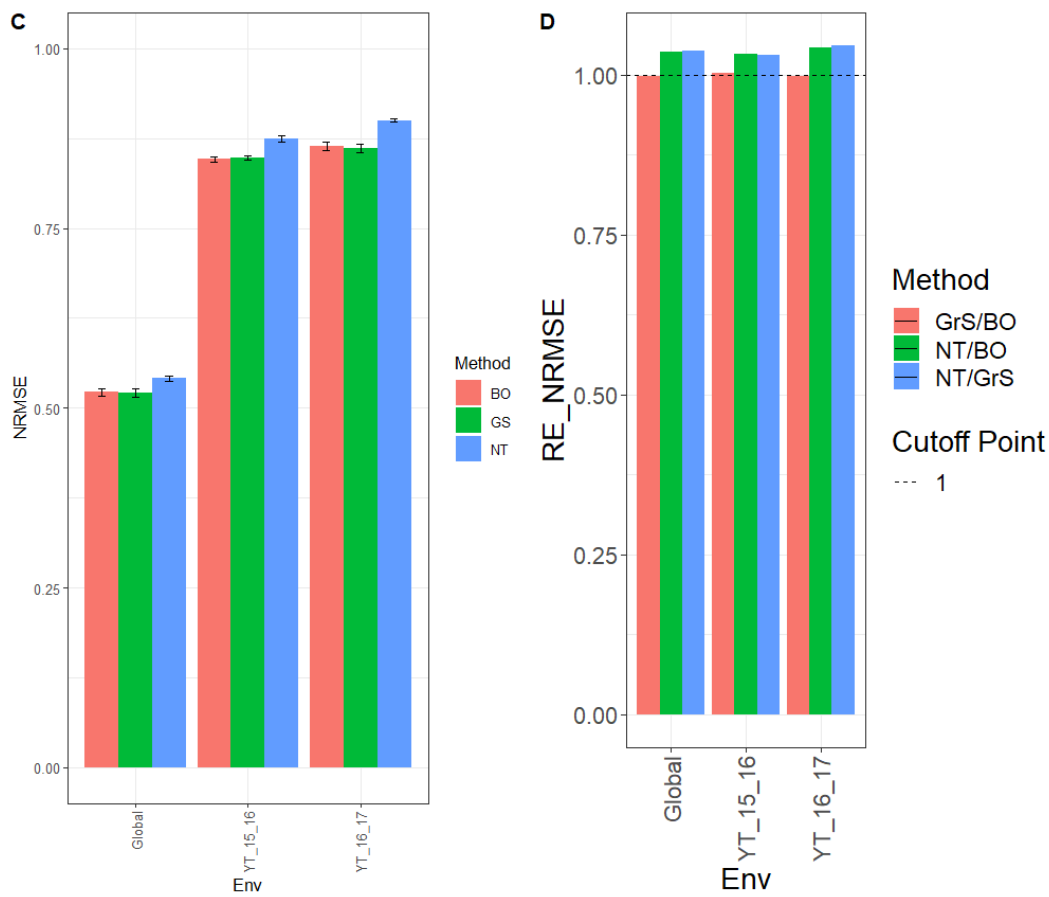
Figure 3. Dataset 3 (Wheat 3) A ) Mean squared error (MSE) and the corresponding standard error (SE) of the methods Bayesian optimization (BO), grid search optimization (GrS), and no tuning (NT) for each environ- ment and across environments of dataset 3. B ) Relative efficiency in terms of the mean squared error (RE_MSE) computed by dividing the MSE of NT and BO; NT and GrS; or GrS and BO. Prediction performance is reported for each environment and across environments in the dataset 3. When RE_MSE>1 the denominator method outperforms the numerator in terms of prediction performance. C ) Normalized root mean square error (NRMSE) and the corresponding standard error (SE) of the methods Bayesian optimization (BO), grid search optimization (GrS), and no tuning (NT) for each environment and across environments of dataset 3. D ) Rela- tive efficiency in terms of the normalized mean squared error (RE_NRMSE) computed by dividing the NRMSE of NT and BO; NT and GrS; or GrS and BO. Prediction performance is reported for each environment and across environments in dataset 3. When RE_NRMSE>1 the denominator method outperforms the numerator in terms of prediction